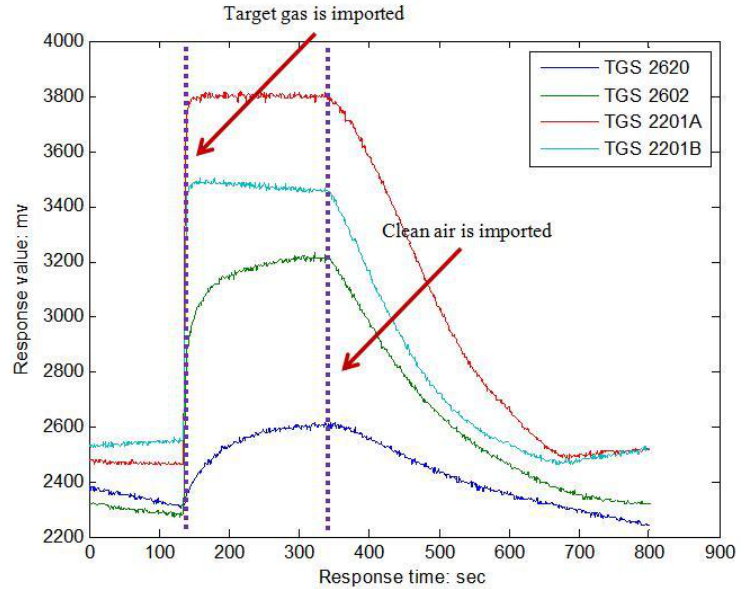
Figure 3. Response of the sensors array.